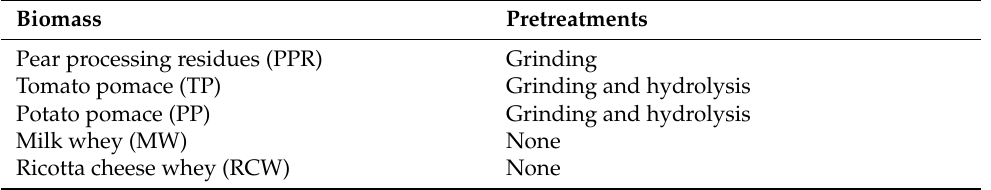
Table 1. Pretreatments on waste biomass before